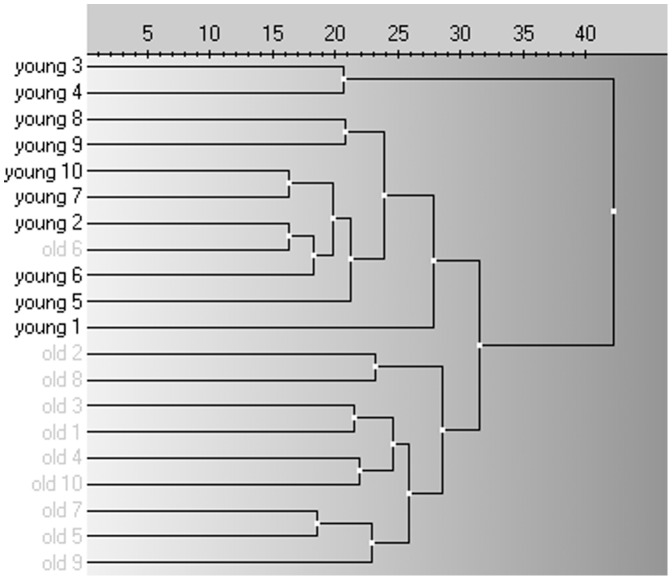
Dendrogram showing hierarchical clustering of patients according to the exploratory miRNA screening panel results.Young patients are shown in black, older patients are shown in grey. The clustering was performed on all 20 patients of the exploratory cohort and on the entire miRNA screening panel, applying complete linkage as the clustering method and Euclidean distance as the distance measure.